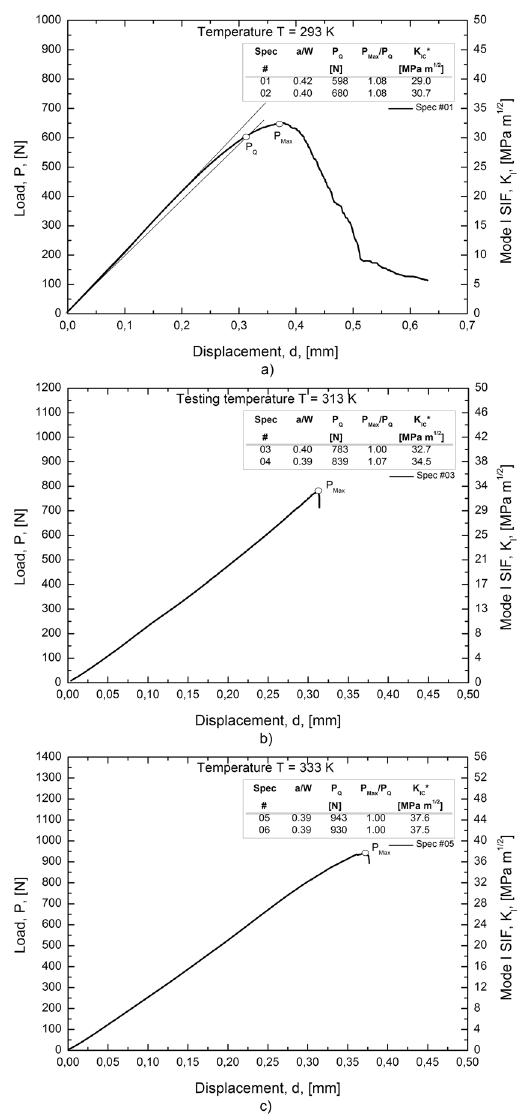
Figure 6. Laod ( P ) and Stress intensity factor ( K I ) vs displacement ( d ) curves obtained from fracture tests of SEC specimens at three different values of the testing temperature: ( a ) T = 293 K (sample #1); ( b ) T = 313 K (sample #3) and ( c ) T = 333 K (sample